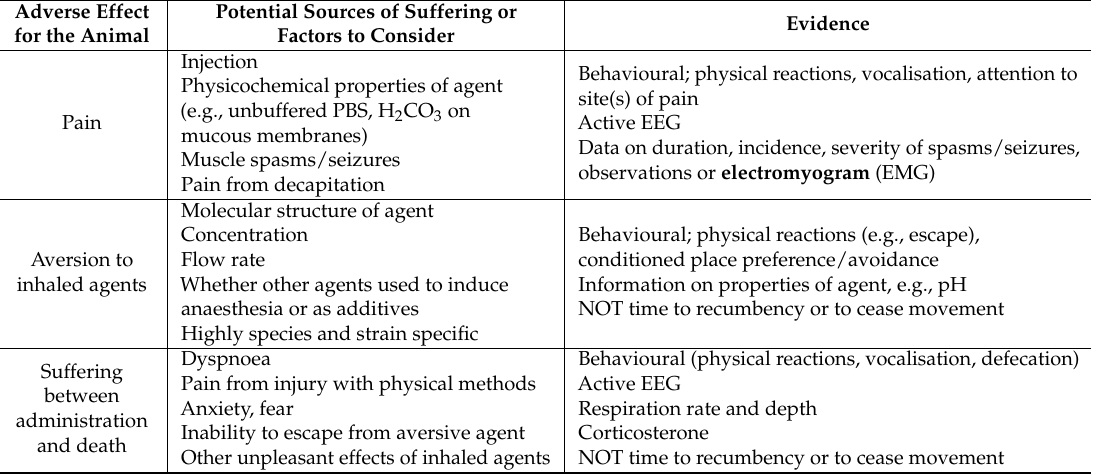
Table 1. Potential adverse effects associated with euthanasia and evidence that can be used to assess